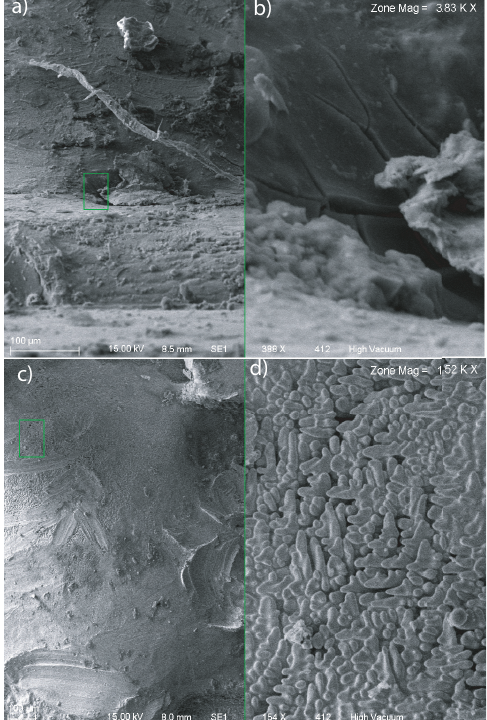
Figure 7. Fracture in the soldering alloy SnAg.